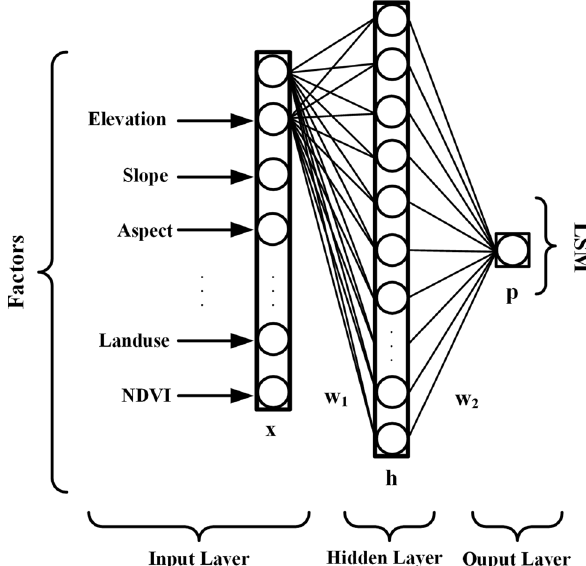
Figure 5. ANN model